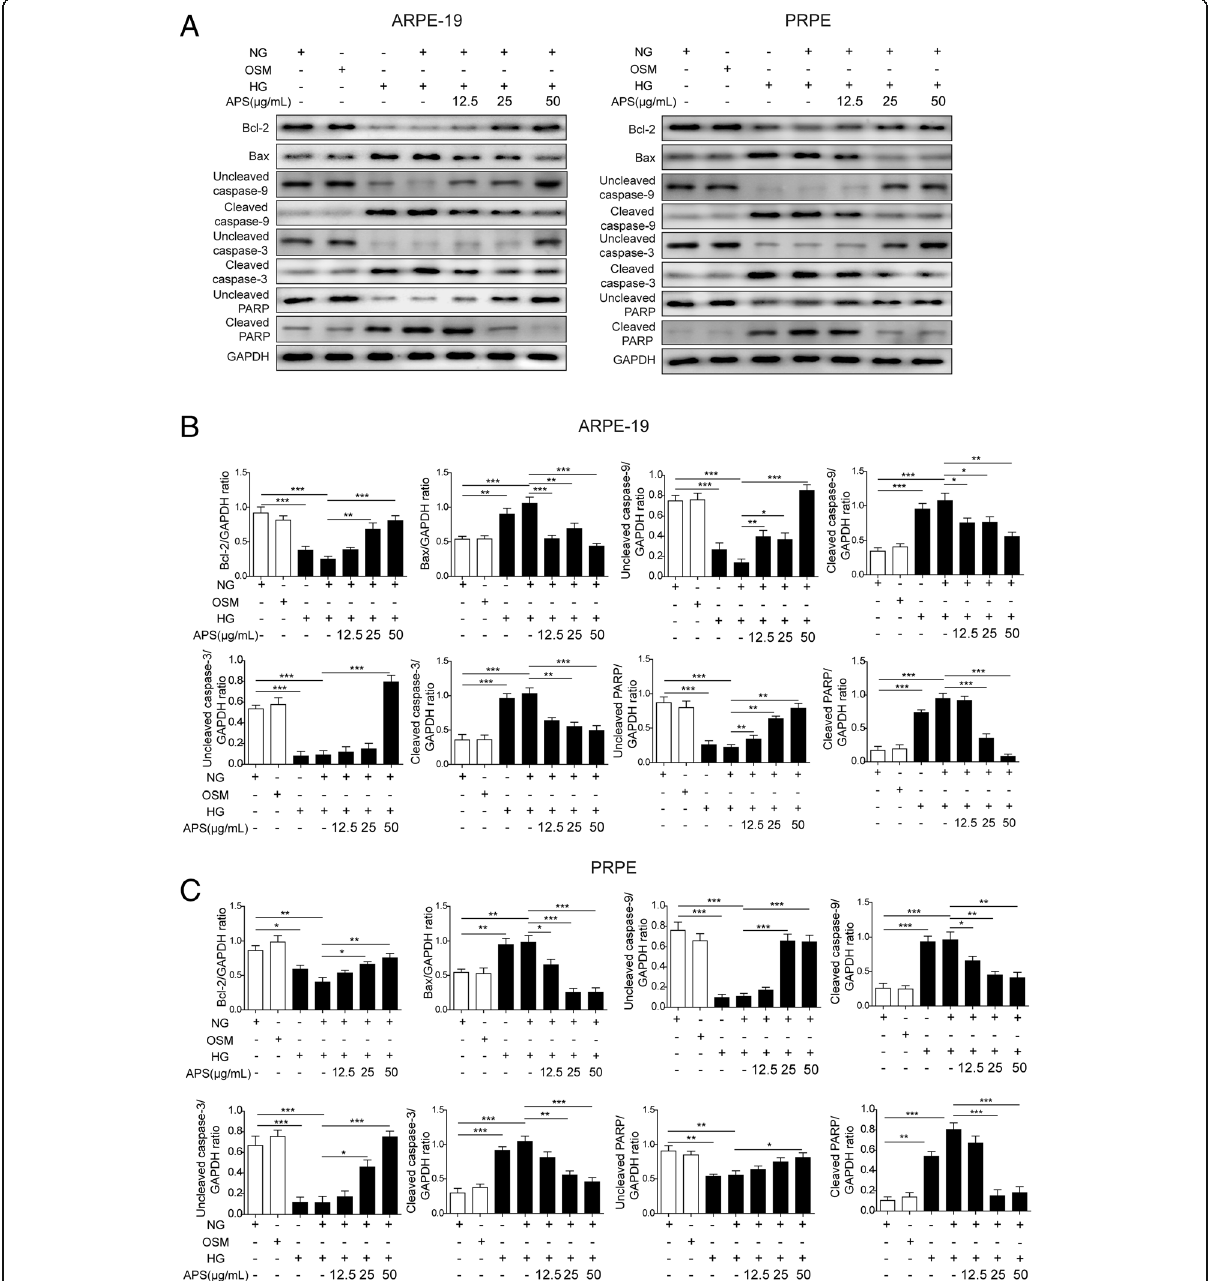
Fig. 5 APS decreased the RPE cells apoptosis via mitochondrial apoptotic pathway. a Western blotting showed treatment with APS significantly decreased the expression of Bax, cleaved caspase-9, cleaved caspase-3 and cleaved PARP which were induced by HG and HG + NG treatment, while increased the expression of Bcl-2 and uncleaved form of caspase-9, caspase-3 and PARP which were repressed by HG and HG + NG treatment in APRE-19 and PRPE cells. b and c. The statistical results of western blotting in APRE-19 and PRPE cells. Error bars represented mean ± SD. *** p < 0.001, ** p < 0.01, * p <